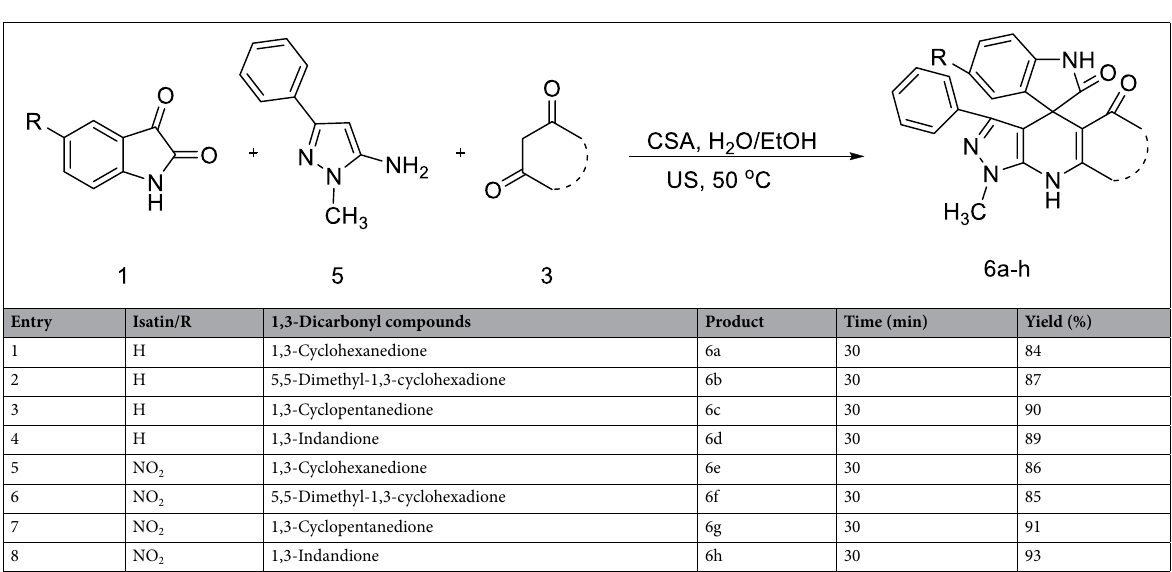
Table 3. Synthesis of spiropyrazolo-indoline-dione (Spirooxindole) derivatives in the presence of catalyst (